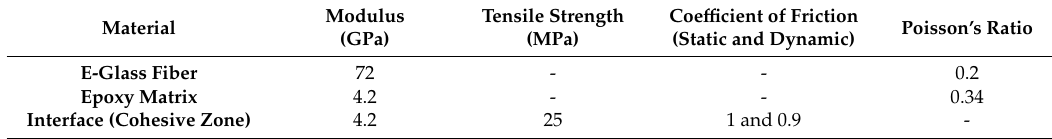
Table 1. Material properties used in the 3D finite element